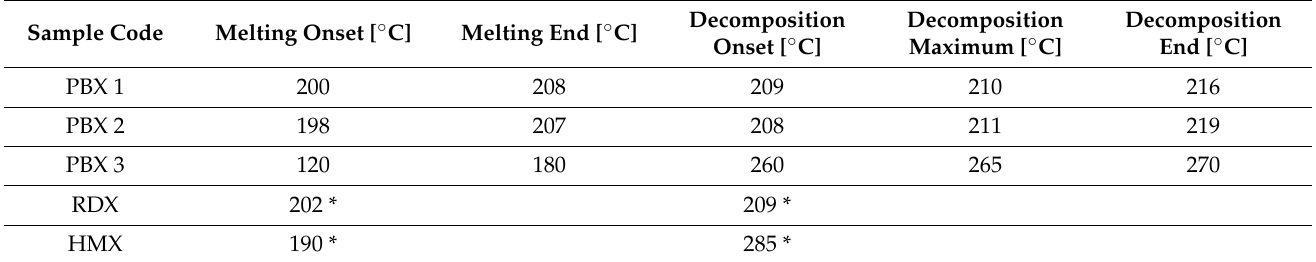
Table 2. Thermal properties of energetic composites.